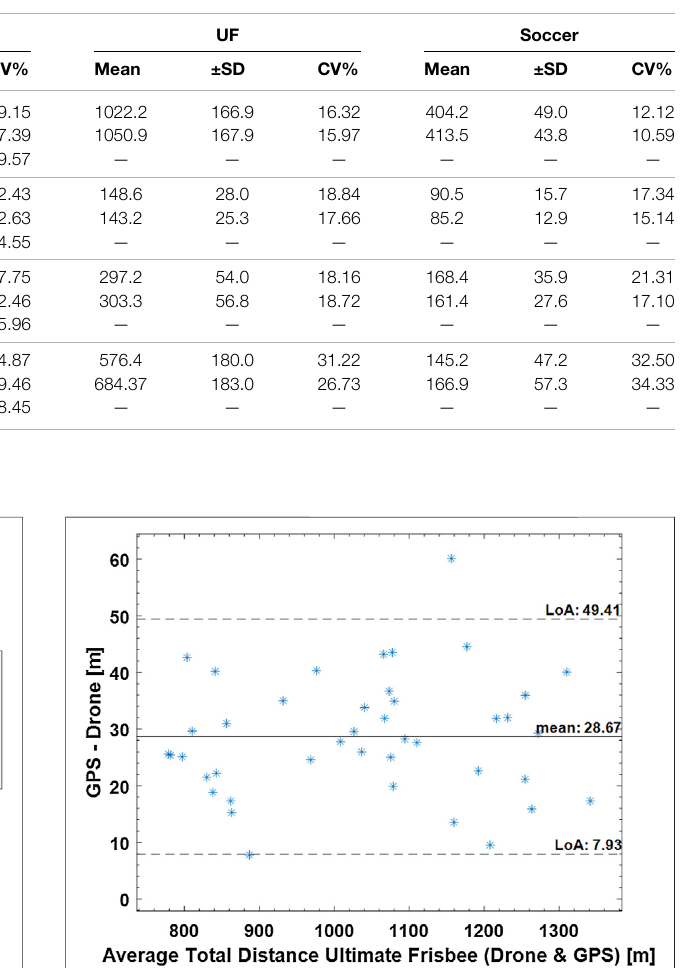
FIGURE 3 | Bland-Altman plot for the total distance covered in a tennis match measured by the drone, GPS, and LPS. Dashed blue lines show the limits of agreement (111.10 m and -25.36 m), and the continuous line shows the mean (42.89 m) between GPS and LPS. Dashed black lines show the limits of agreement ( − 0.20 m and − 21.05 m), and the continuous line shows the mean ( − 10.63 m) between the drone and LPS.